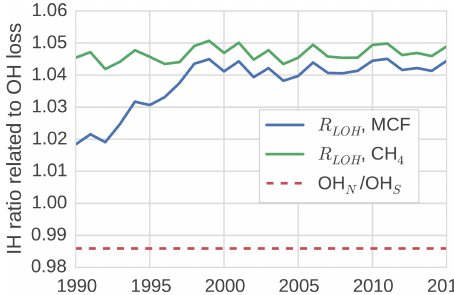
Figure 4. The ratio between tracer lifetime with respect to OH loss in the SH troposphere and NH troposphere (see Eq. 8). Additionally, the IH ratio in OH concentrations is